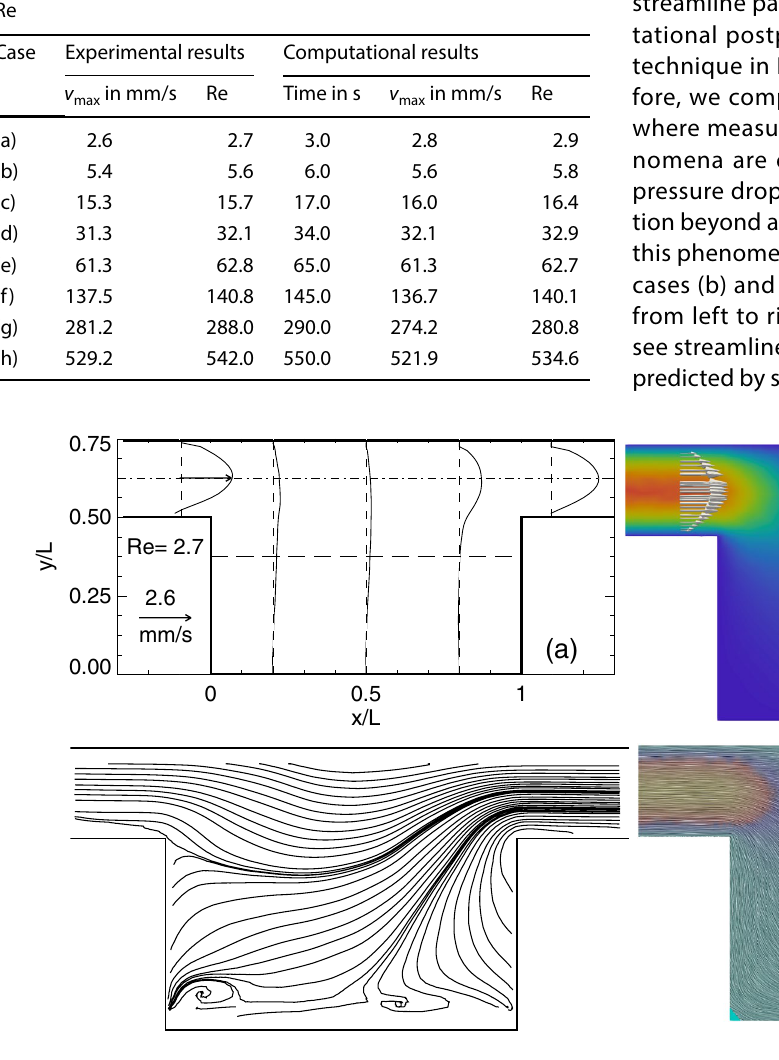
Fig. 6 Comparison of measurement and calculations: Case (a) PIV left column and CFD right column. Selected velocity profiles (top row) and streamlines (bottom row) are